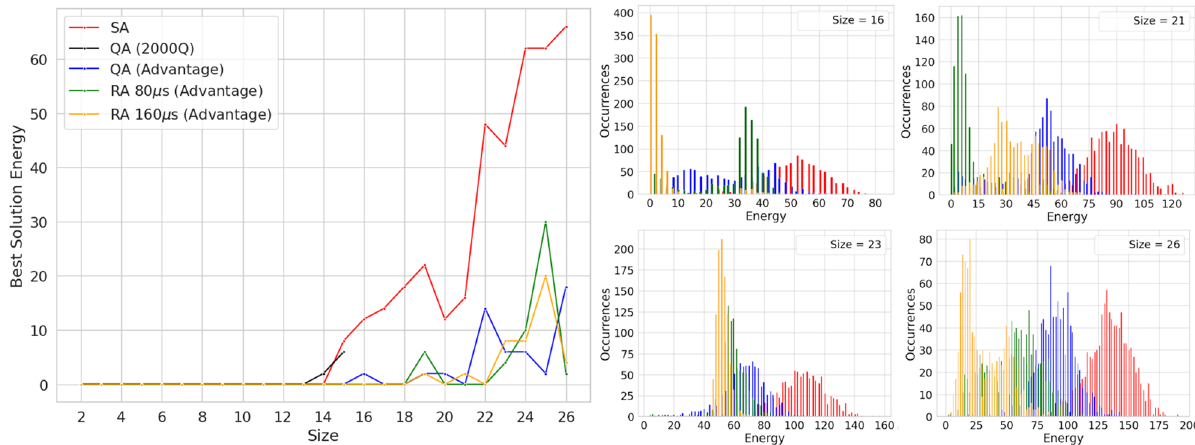
Figure 3. Solutions obtained with Simulated Annealing (SA), Quantum Annealing (QA) and Reverse Annealing (RA) on instances of increasing size , with timespan equal to size + 1 . Greedy and Tabu solutions were excluded from the plot due to their high energy. ( Left ) Comparison of the best solutions for each solver, i.e., those with the lowest energy. ( Right ) Distribution of all solutions sampled for selected cases, to compare their energy and the number of